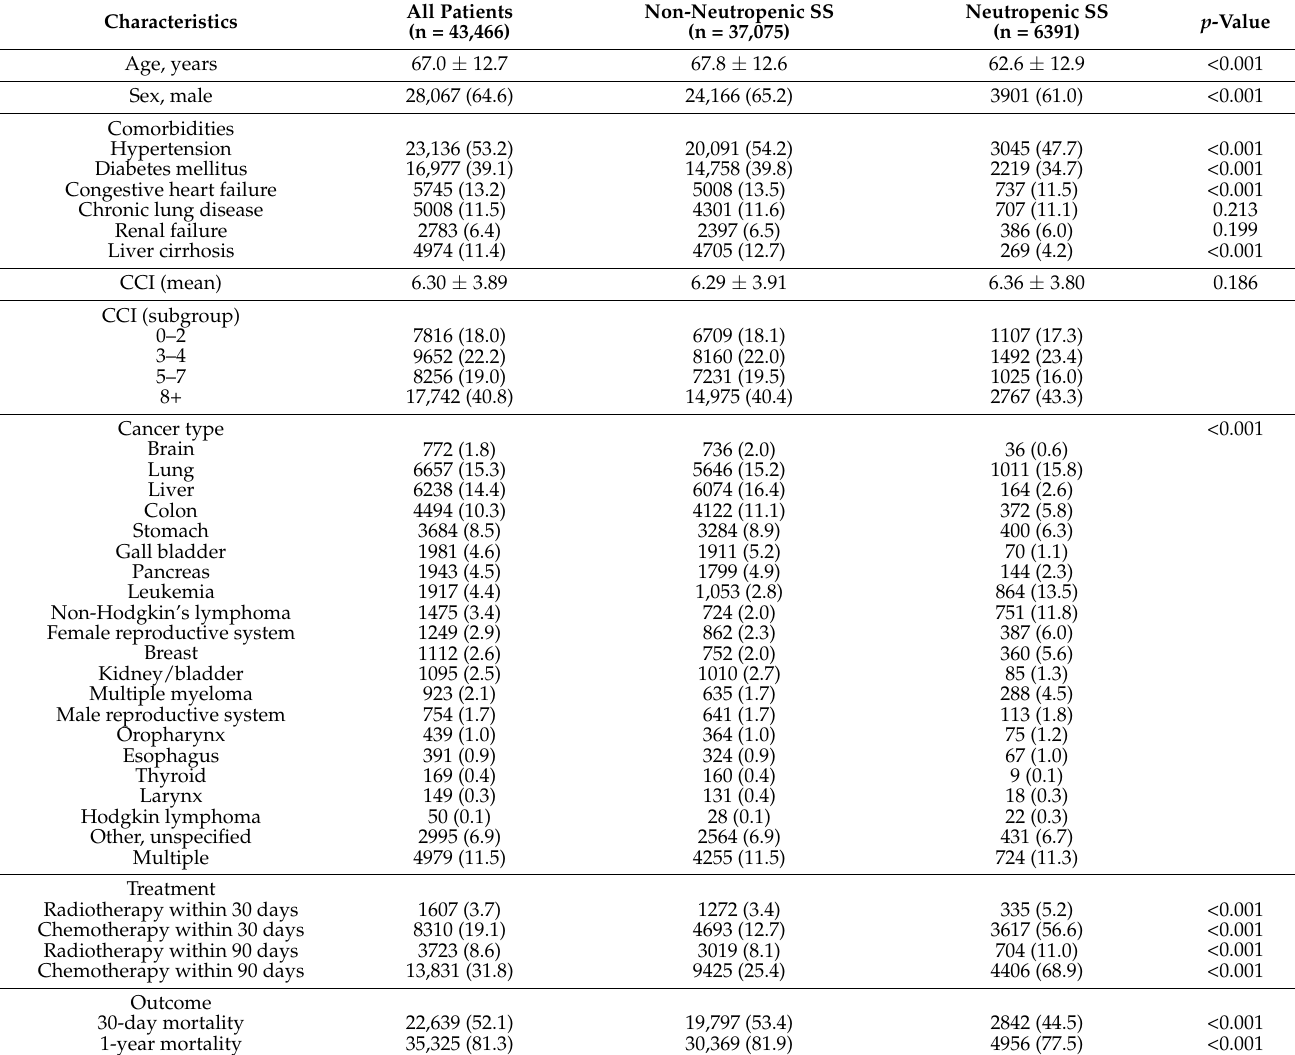
Table 1. Baseline and clinical characteristics of septic shock patients with and without